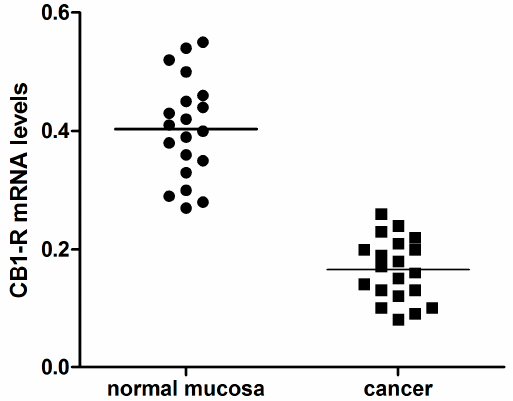
Figure 5. CB1 receptor gene expression levels (mean ± SE) in intestinal normal mucosa and cancer tissue from 20 patients with colorectal cancer. Data expressed as molecule numbers of CB1 receptor gene mRNA /molecule numbers of β -actin mRNA.